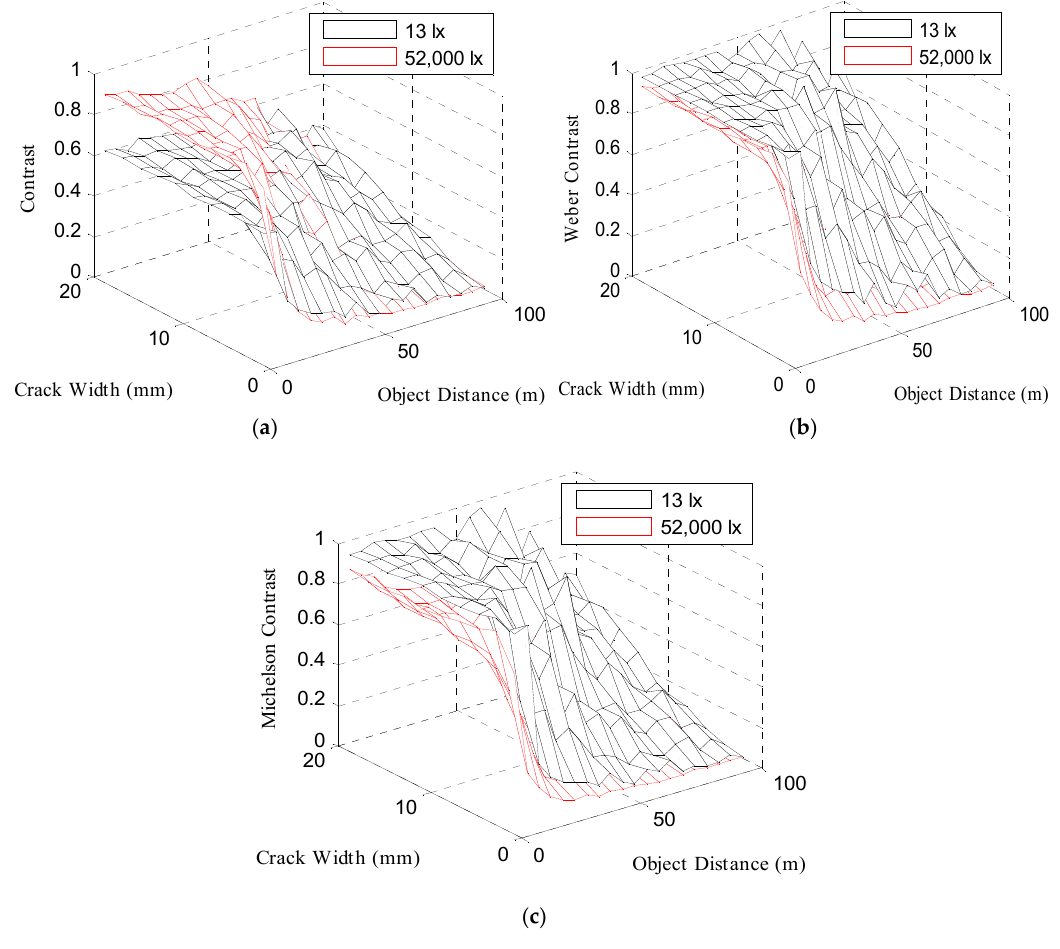
Figure 18. Three-dimensional graphs showing the ( a ) contrast, ( b ) Weber contrast, and ( c ) Michelson contrast changes depending on the image acquisition distance and crack width.